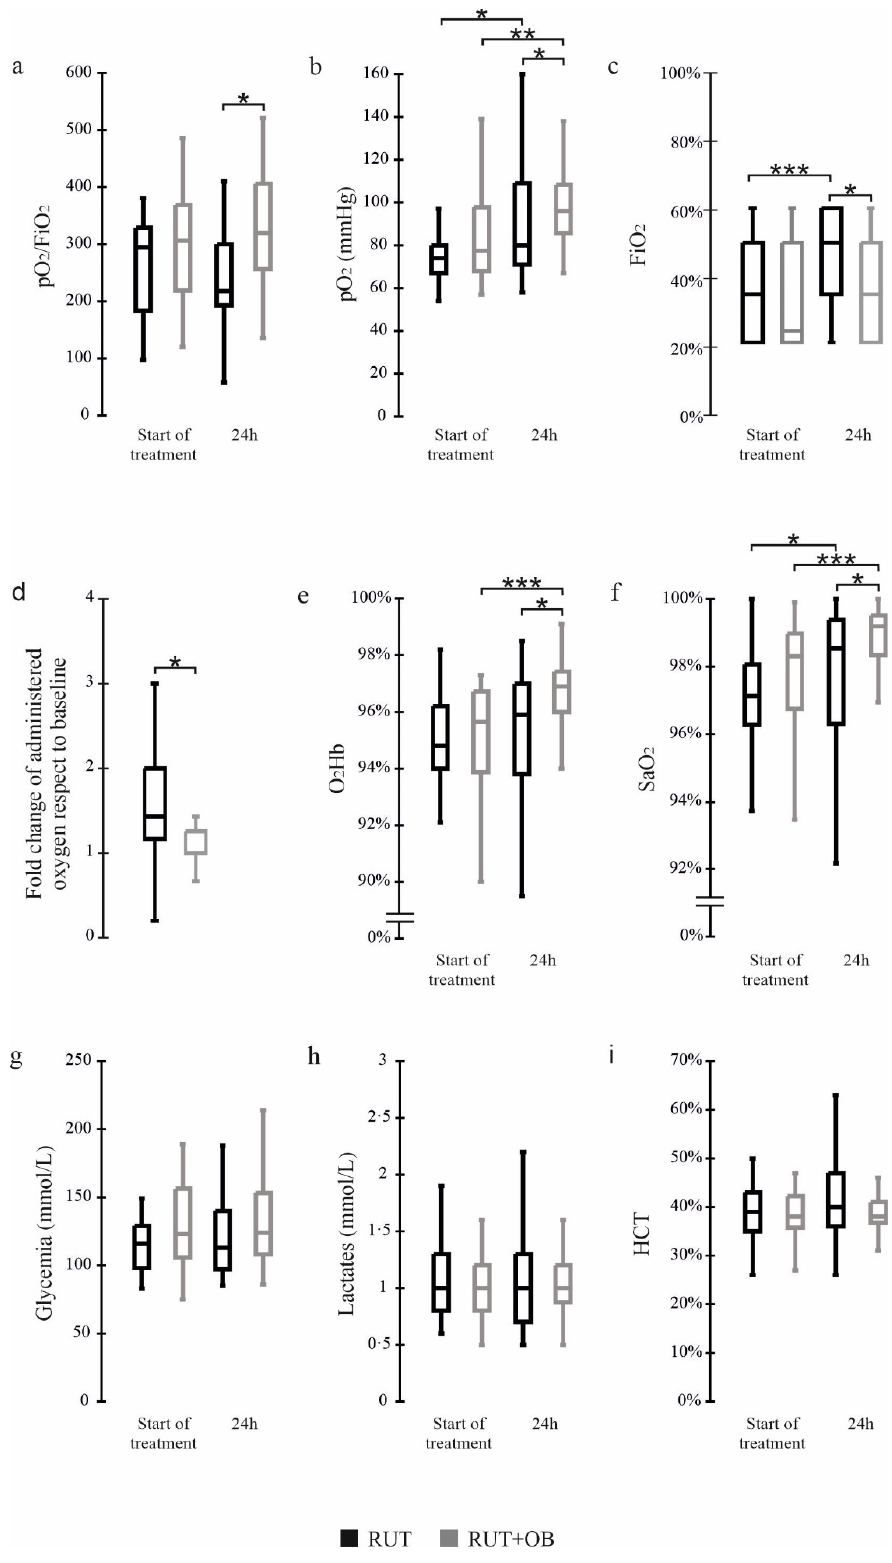
Figure 2. Results of blood gas analyses. Box end whiskers plots showing the value distribution of ( a ) PO 2 /FiO 2 ration, ( b ) pO 2 , ( c ) FiO 2 , ( d ) Fold change of administered oxygen respect to baseline, ( e ) O 2 Hb, ( f ) SaO 2 , ( g ) glycemia, ( h ) lactates, and ( i ) HTC obtained by routine laboratory analysis. Where present, statistical significance has been reported between RUT and RUT+OB groups at each time point, as well as for each group over time. *: p ≤ 0.05; **: p ≤ 0.001; ***: p ≤